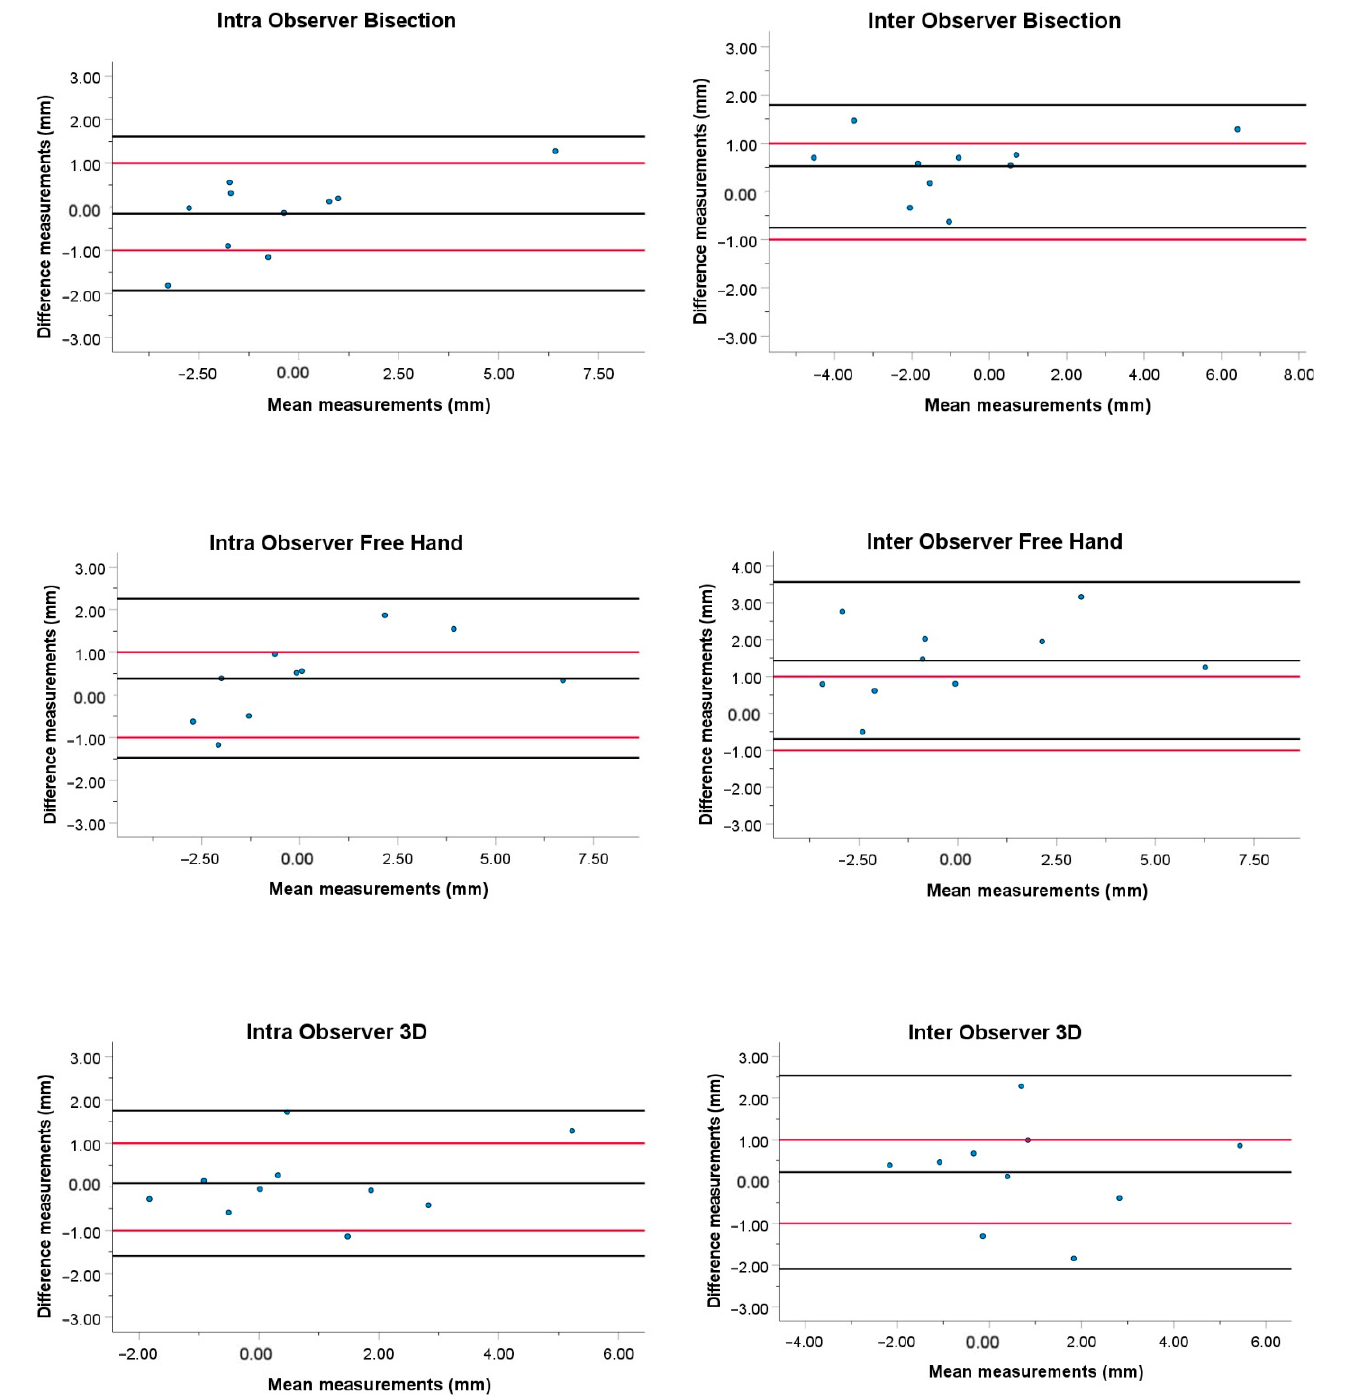
Figure A1. The x -axis in all the plots represents the mean of both measurements (mm) but does not say anything about the accuracy because there is no gold-standard, and the actual difference between left and right ramus heights is unknown. The y -axis show the difference between both measurements (intra-observer) and both observers (inter-observer) (mm). The black lines represent the 95% confidence intervals (upper and lower black lines) and the average of the measurements (middle black line). The red lines represent our clinically acceptable measurement error of 1 mm.